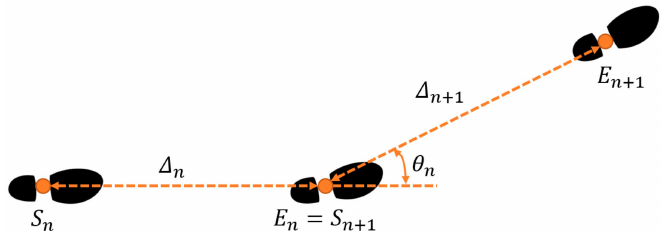
Figure 2. Illustration of stride length , ∆ , and stride angle, θ . Orange dots on footprints represent consecutive zero-velocity